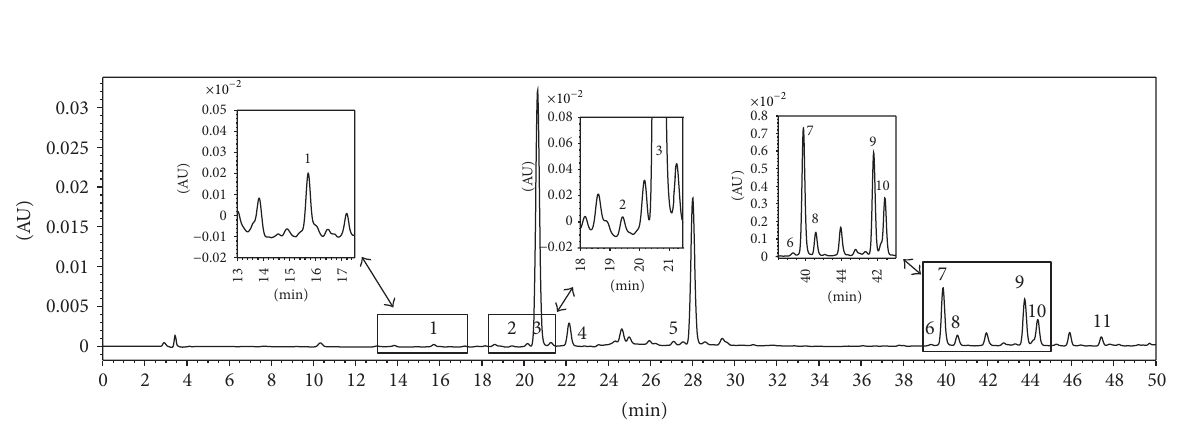
Figure 5: Chromatogram of the ethanol extract of the investigated apple fruit sample ( 𝜆 = 320 nm, cv. “ˇSampion”). Numbers indicate the peaks of analytes: 1: procyanidin B1; 2: (+)-catechin; 3: chlorogenic acid; 4: procyanidin B2; 5: ( − )-epicatechin; 6: rutin; 7: hyperoside; 8: isoquercitrin; 9: avicularin; 10: quercitrin; and 11: